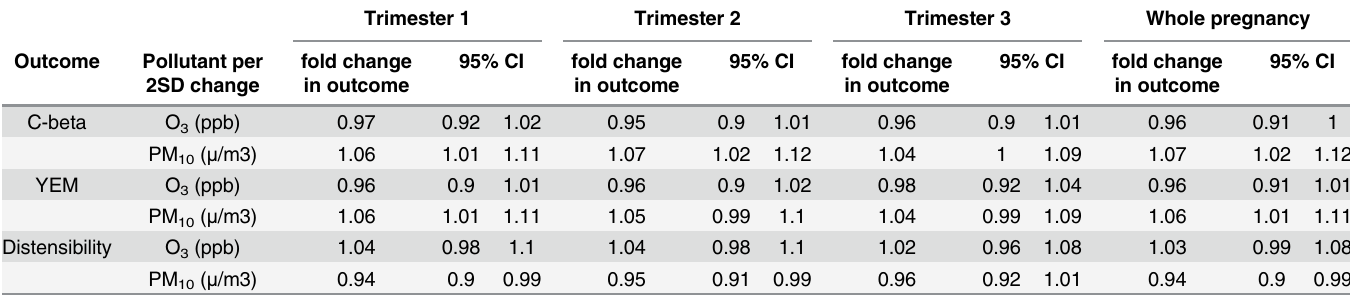
Table 2. Results from a multi-pollutant model * of PM 10 and O 3 (N =